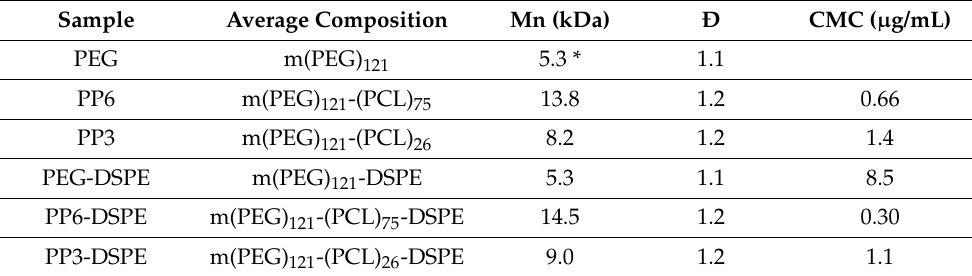
Table 1. Average composition, molecular weight, Ð and